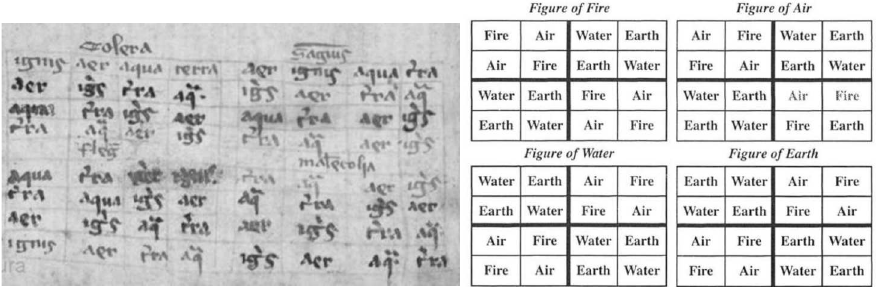
Figure 9. left The elemental figure as it occurs in the ACIV. Source: Biblioteca Virtual del Patrimonio Bibliogr´afico, Manuscript